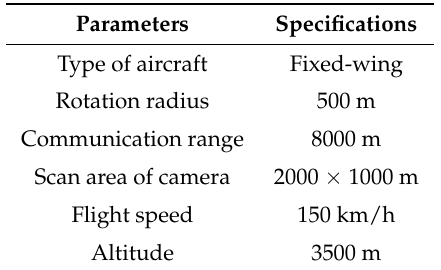
Table 1. The simple Unmanned Aerial Vehicle (UAV)